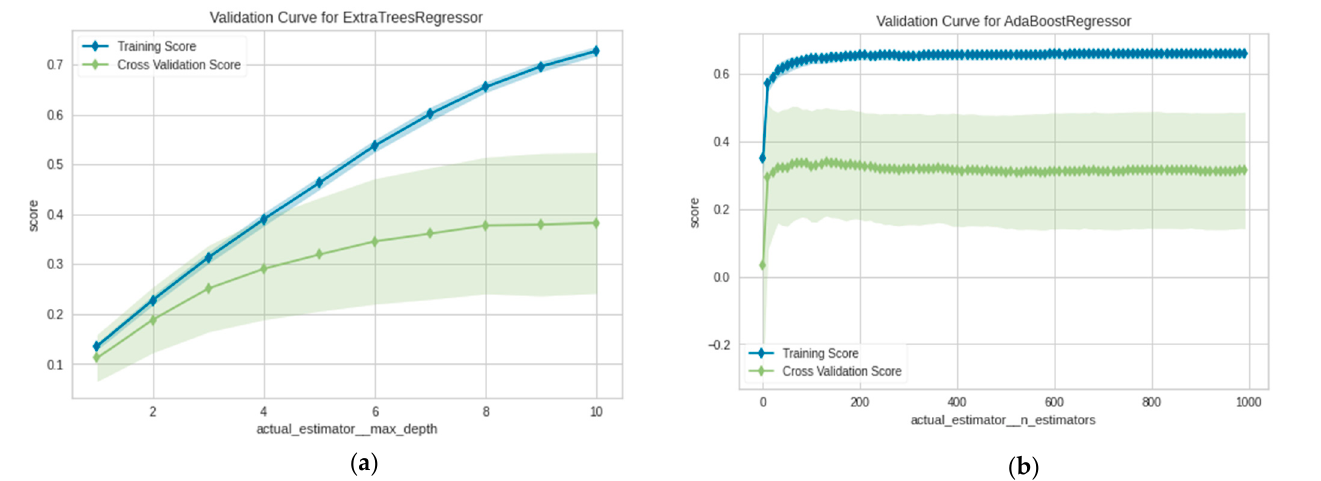
Figure 11. Cross validation of ( a ) Extra Tree; ( b ) AdaBoost.